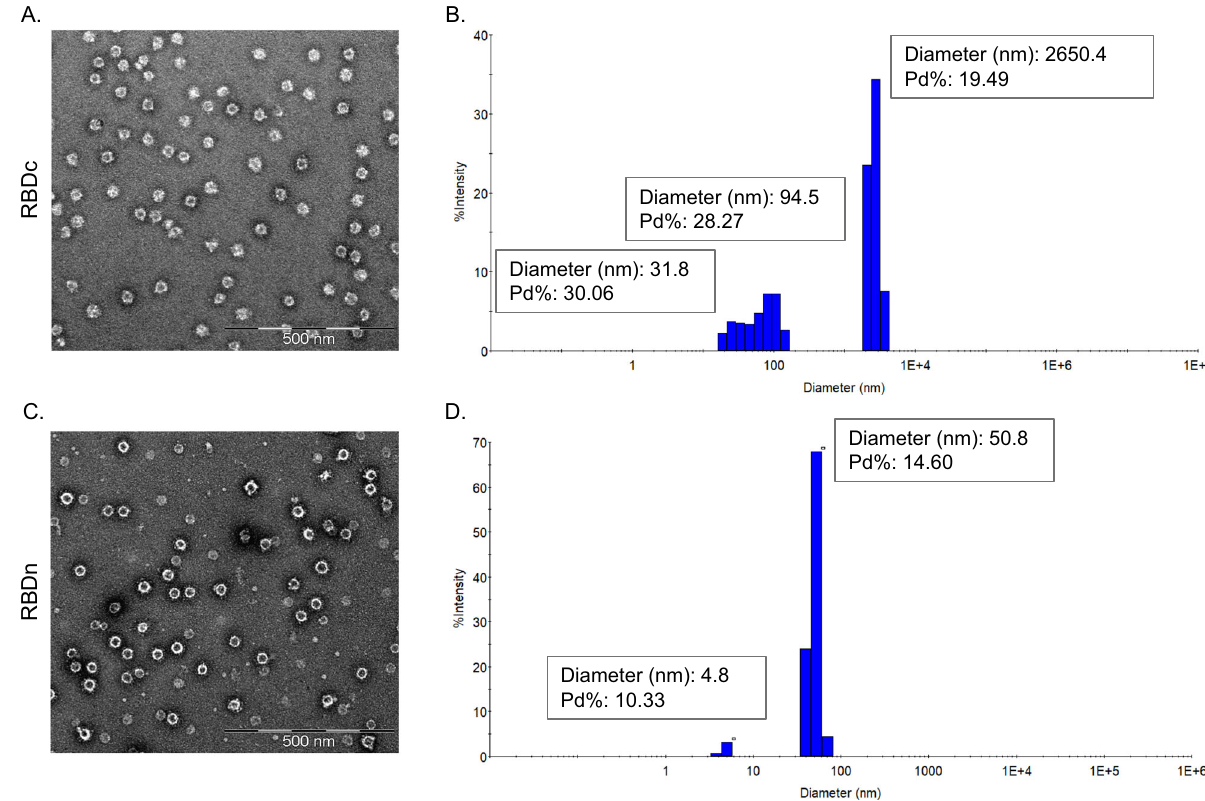
Fig. 2 Vaccine quality assessment. a , c Transmission electron microscope (TEM) images of the negatively stained puri fi ed RBDc-CLP or RBDn-CLP vaccine. Scale bar is 500 nm. b , d Histogram of the % intensity of the puri fi ed RBDc-CLP or RBDn-CLP particles from DLS analysis. Annotated are the average diameter and polydispersity (Pd%) for the particles.